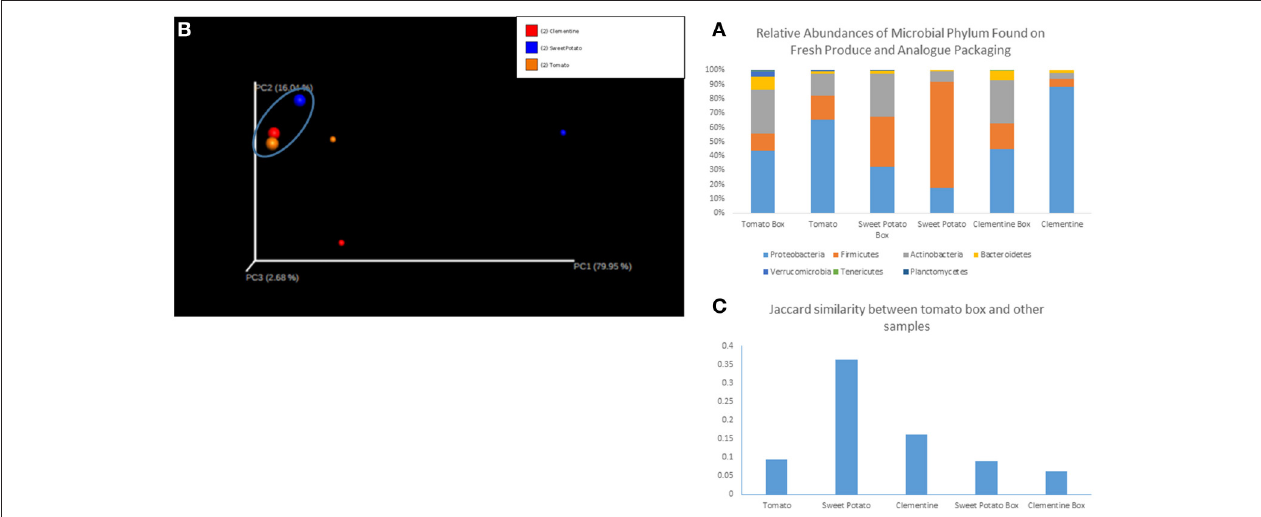
FIGURE 1 | (A) Relative abundances of microbial phylum found on fresh produce and analog packaging. (B) Principal coordinates analysis of samples. The cluster of samples in the circle at the top left (larger circles) represent corrugated cardboard associated samples. Red circles represent clementine and analog box, blue represents sweet potato and analog box, and orange represents tomato and analog box. (C) Jaccard similarity between tomato corrugated cardboard and other samples.